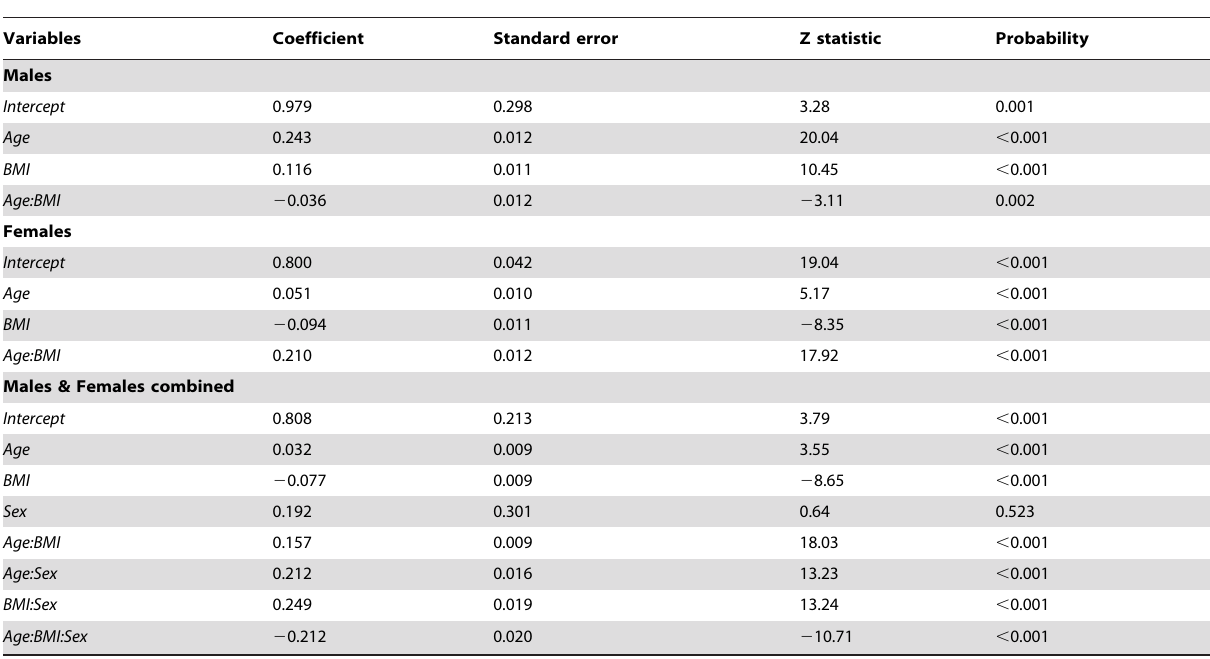
Table 2. Coefficients showing the influence of age, BMI and sex on NLR.